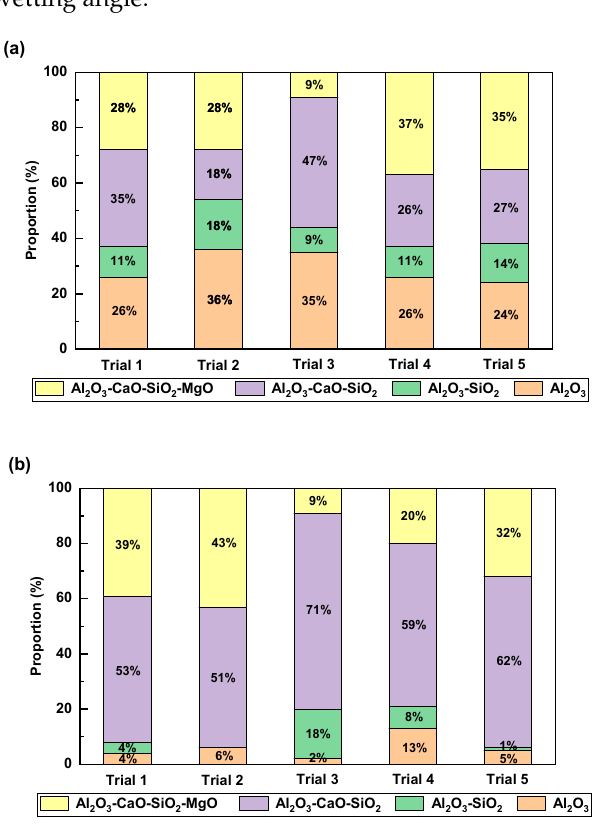
Figure 17. Comparison of inclusion types in steel samples taken from ( a ) ladle and ( b ) casting billet for the five industrial trials.